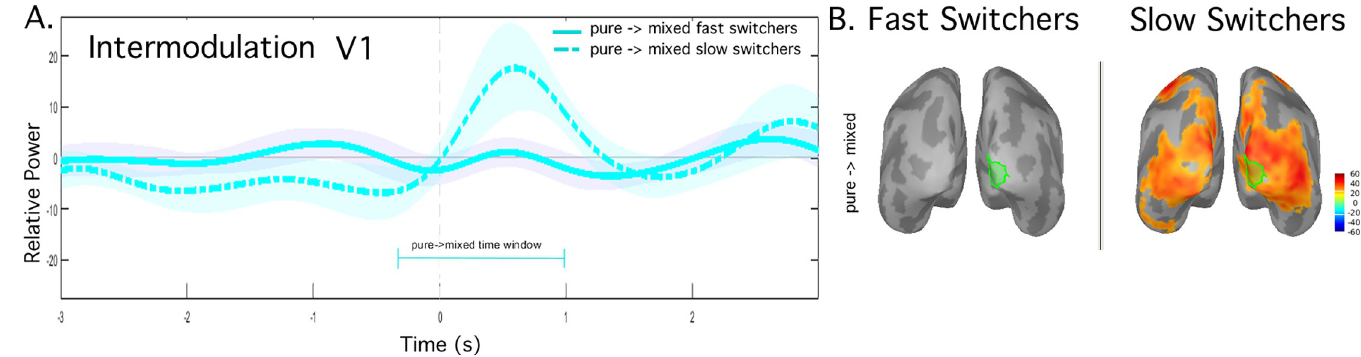
Fig 4. Intermodulation frequency power fluctuations for BR: Fast vs. Slow Switchers, group-average (n = 5 per group). A. 2.5 Hz power over time extracted from visual area right V1 for condition BR and pure to mixed alternations. For Slow Switchers, the dashed cyan time course shows power fluctuations when alternating between epochs with pure dominance (i.e. no-mixed percept) to epochs that sometimes contained a mixed percept. Pale color fill indicates the standard error of the mean (SEM). The equivalent data is shown for Fast Switchers in solid cyan time course. B. Maximum change of 2.5Hz signal power (maximum minus minimum) over the time window, (-300, 1000)